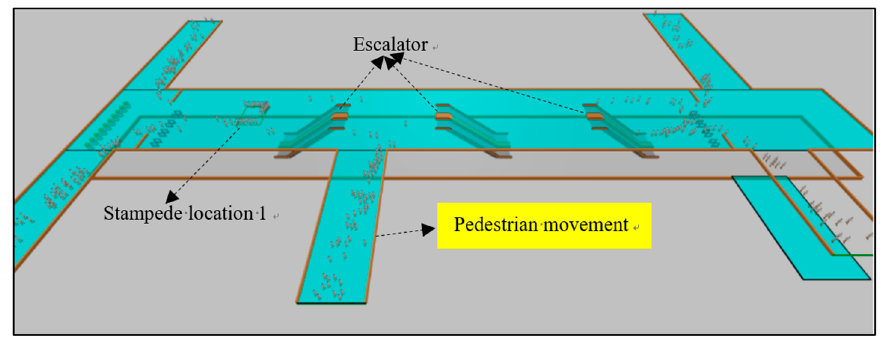
Figure 3. Simulation setting and pedestrian movement of the subway station.